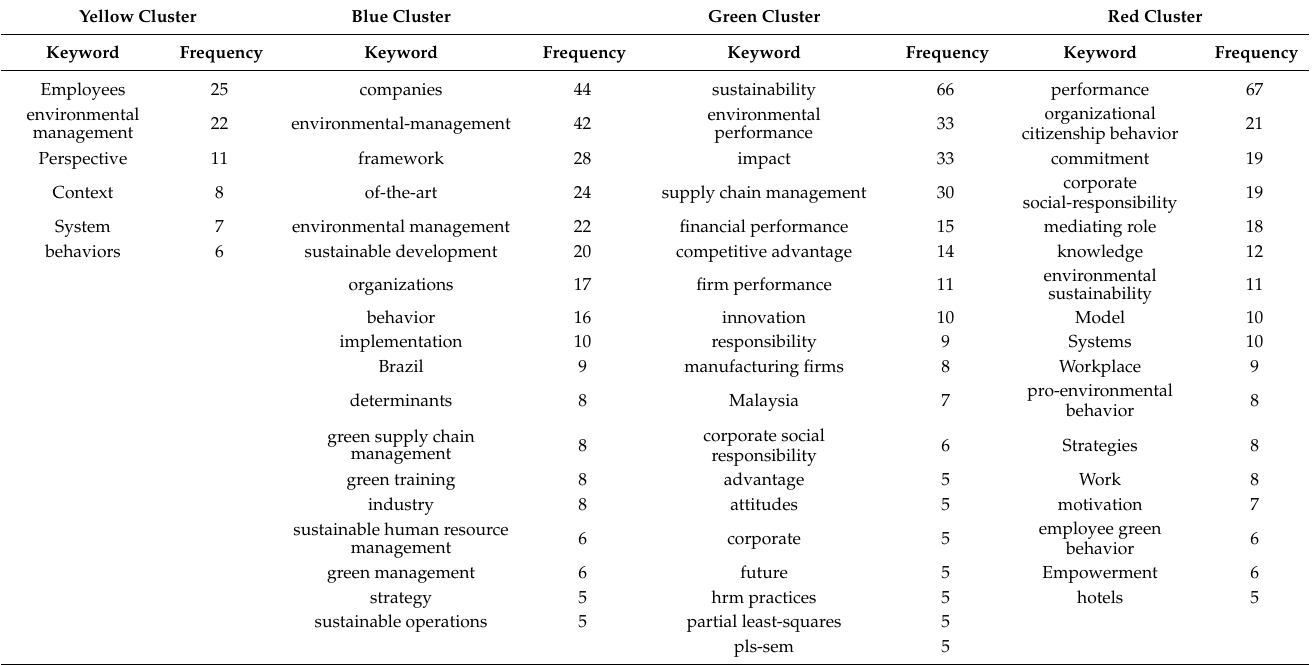
Table A5. Keywords from the keyword co-occurrence